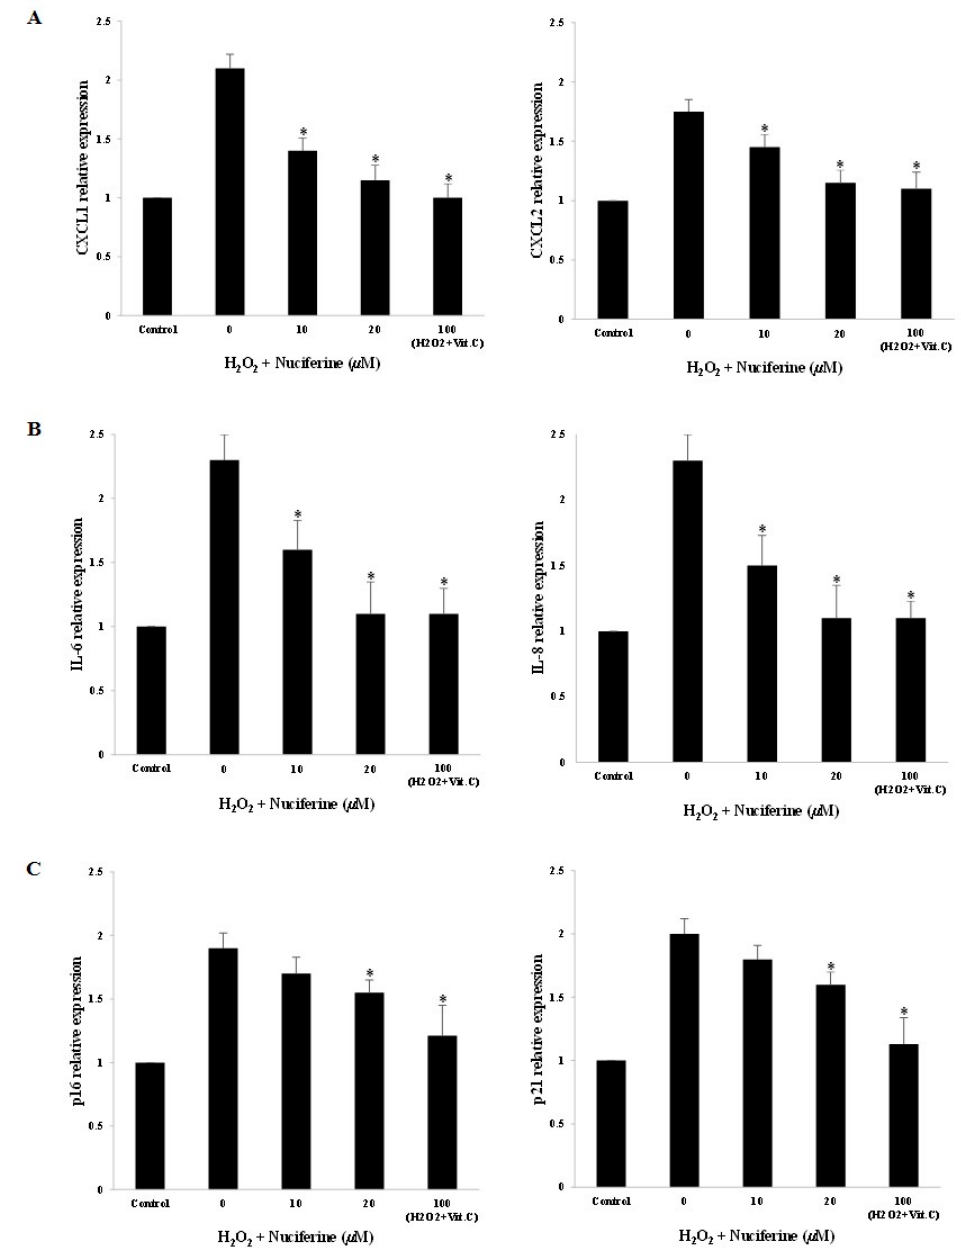
Figure 3. Downregulating effect of nuciferine on SASP gene expression upon H 2 O 2 -induced fibroblast senescence. After co-incubation with H 2 O 2 (300 µ M) and nuciferine (0–20 µ M) or vitamin C (100 µ M), the mRNA from control- and treated-fibroblasts were isolated and quantified by quantitative real-time PCR. ( A ): The expression of C-X-C motif chemokine ligands (CXCL1 and CXCL2) genes. ( B ): The interleukin (IL)-6 and IL-8 gene expression. ( C ): The expression of p16 and p21 (cell cycle inhibitors) genes. The average relative expressions of SASP genes between control- and treated cells were analyzed with one-way ANOVA (* as p <